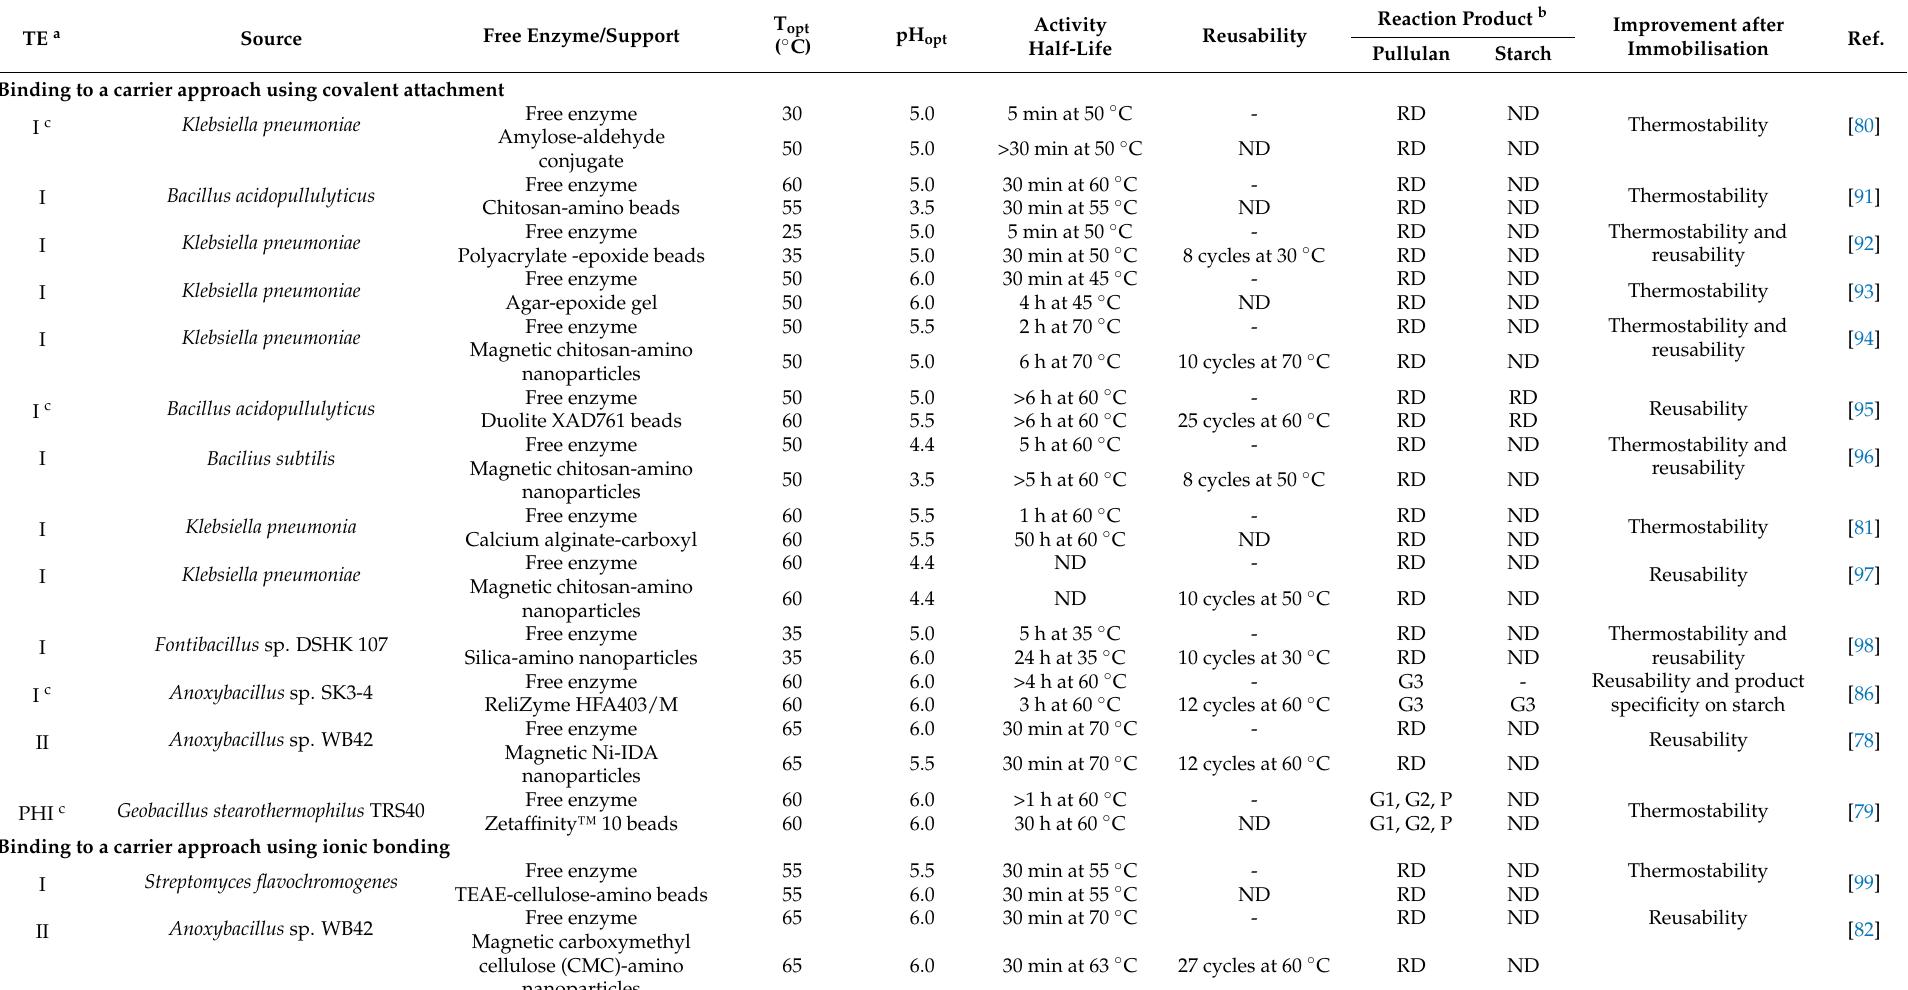
Table 5. List of single immobilised pullulan-degrading enzymes compared to their free enzyme